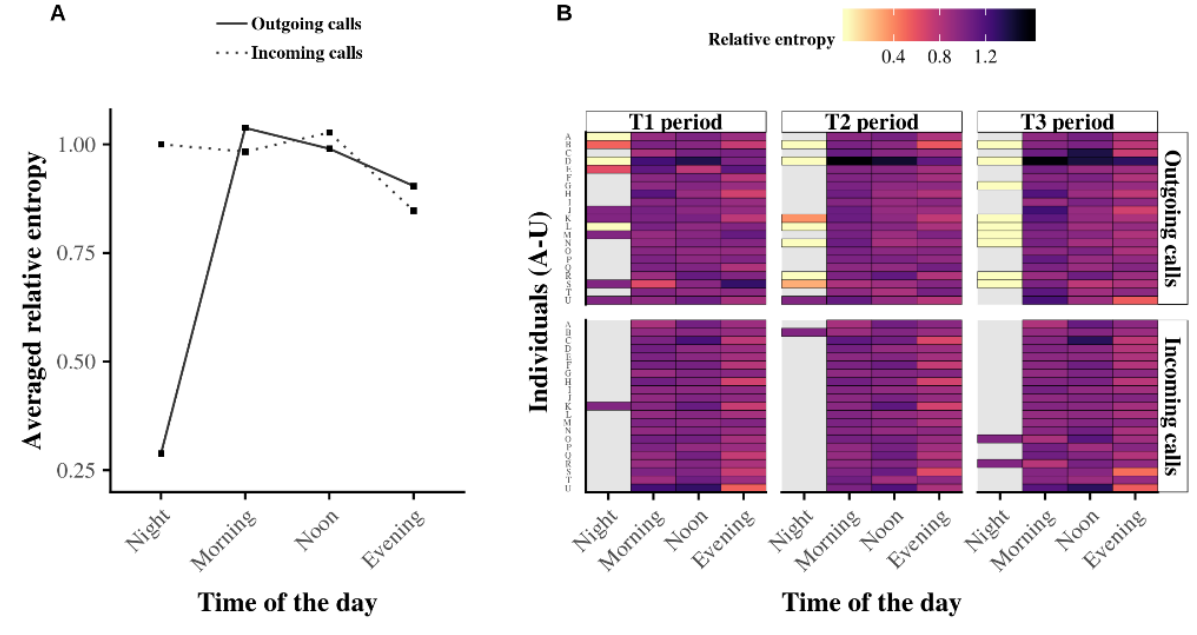
Figure 7. Relative entropy at the individual level. Panel A shows the averaged relative entropy for both outgoing (black curve) and incoming (dashed curve) telephone calls. Panel B summarizes the relative entropy of all 21 egos in a heat map. Light (dark) colors correspond to low (high) entropy, and gray indicates missing values. Although individuals have their own alter specificity during the daytime, the average relative entropy of the population is similar, except at nighttime when too much data are missing to obtain a significant result.